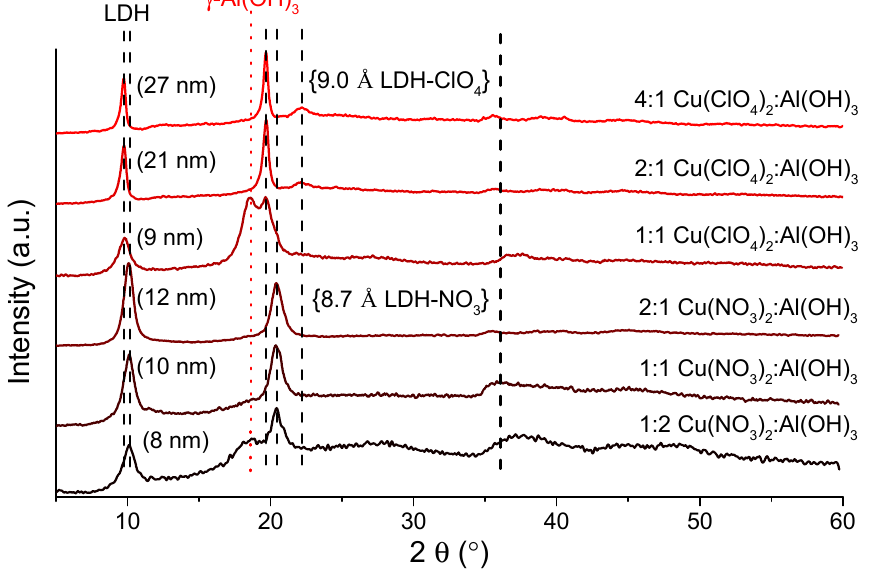
Figure 1. XRD patterns of the CuAl 4 –X n − –LDHs, formed with various X n − interlayer anions. The initial Cu:Al molar ratio is shown to the right side of the XRD patterns; crystallite thicknesses are denoted next to the first reflection. Reaction conditions: 6 h pre-milling, 96 h stirring, 90 °C reaction temperature. The basal spacings in two representative cases are shown in curly brackets.